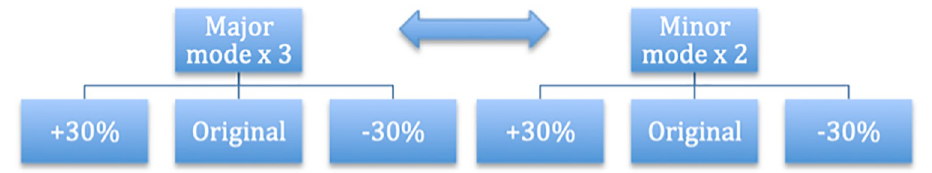
Fig 2. Diagram showing how music pieces will be transposed and how tempos will be